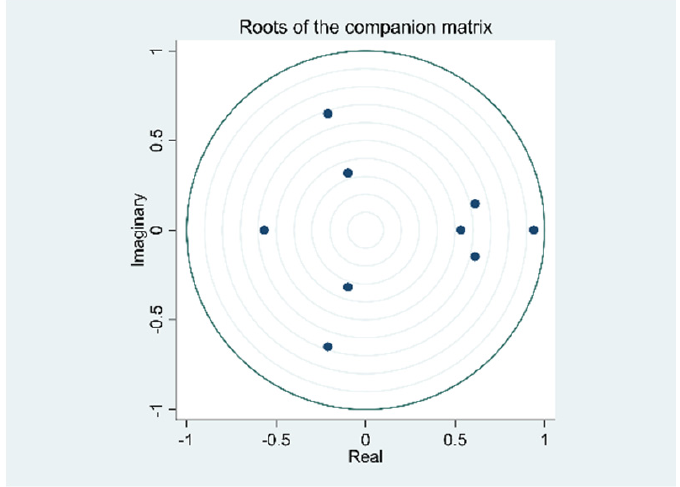
Figure 1. Balance test of data concerning the electricity consumption of the whole of society. Table 2 shows that the vsw index can significantly promote the electricity consumption of the whole of society and can pass the 90% robustness test. Additionally, the dst index can increase the electricity consumption of the whole of society and can pass the 95% robustness test. The Var model as the impulse response analysis studies the effect of the changes of the error term on the system, which is the Granger causality. Though the empirical results cannot present the true causality, the Granger causality can still test whether one time series S is the changing factor of another time series T. It tests whether the prediction result of the time series variable T when the past information of time series S and T are both known and is more effective than the prediction of time series T by using the past information of T alone rather than using the direct impact between the indicators. Figure 2 is the impulse response function graph that shows the Granger causality between the electricity consumption of the whole of society and space weather. Additionally, we can learn from Figure 2 that during the optimal lag period, society’s electricity consumption increased, responding to the dst and vsw index, which means that the solar activity and geomagnetic activity can explain the promotion of the electricity consumption of society. During the first period, the electricity consumption of the society decreased, responding to dst; however, during the second and third period, the consumption increased and